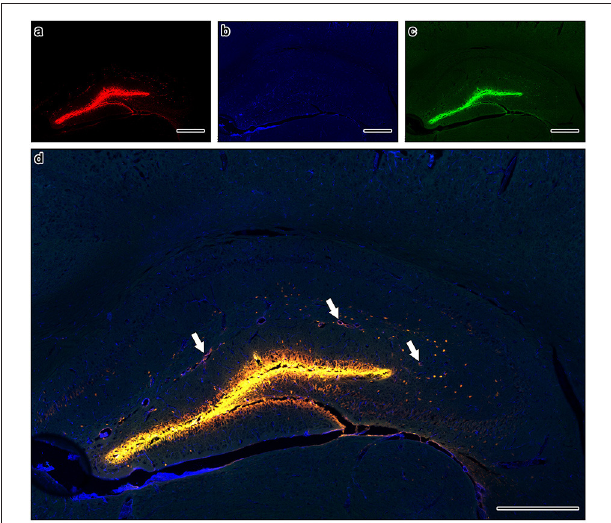
FIGURE 6 | Composite tile scan of confocal images of the distribution of intracerebrally injected A β (a) in relation to collagen IV (b) and SMA (c) . The image was taken at 400mm anterior to the injection site in an atenolol (Ate) injected mouse, to avoid any artifacts induced by the injection tract, relying instead on the pattern of distribution of the fluorescently injected A β away from the direct injection. Arrows on merged image (d) indicate arteries with A β in the intramural perivascular drainage pathways. Scale bars